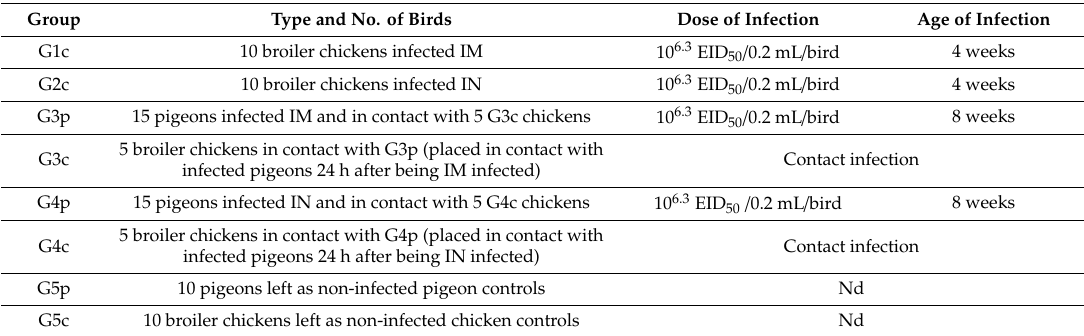
Table 1. Experimental